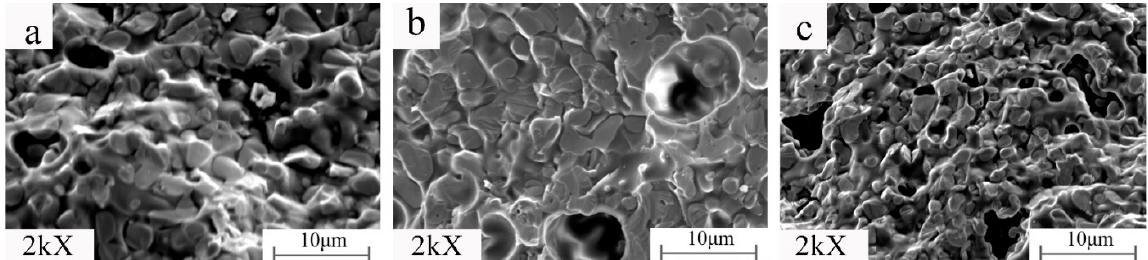
Figure 11. Samples prepared by simulating different susceptors warming rates: ( a ) AC; ( b ) SiC; ( c ) AC/SiC = 1.